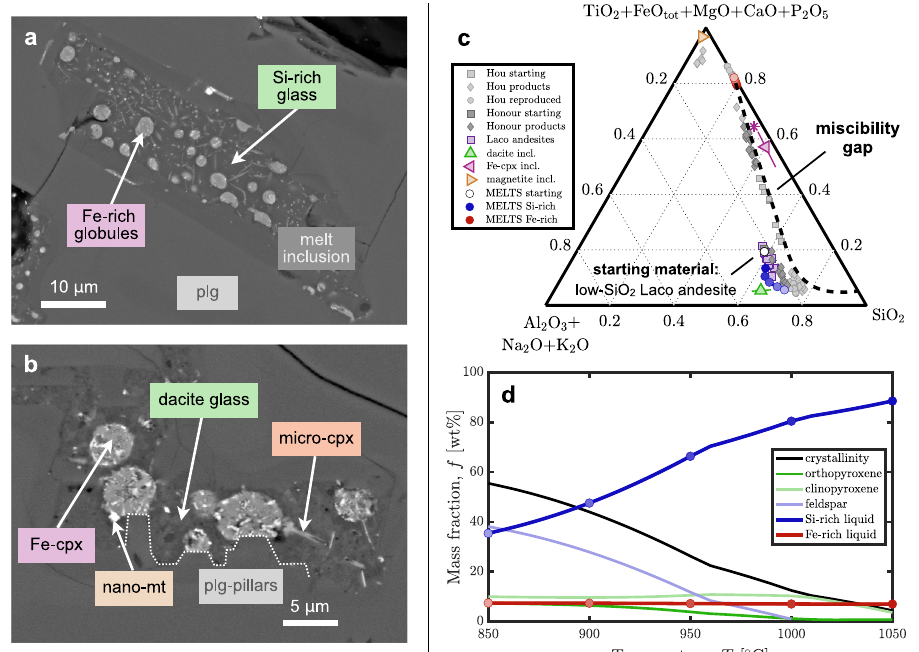
Fig.3|LiquidimmiscibilityinElLacoandesite. Back-scatteredelectronimagesof plagioclase-hosted (plg) melt inclusions from ore-hosting andesites; a Fe-rich glo- bules in Si-rich matrix; b higher magni fi cation image shows high-SiO 2 dacite glass matrix with some clinopyroxene micro-phenocrysts (micro-cpx), and Fe-rich glo- bulescomprisedofFe-clinopyroxene(Fe-cpx)withsomenanocrystallinemagnetite (nano-mt); plagioclase shows pillar structures indicative of melt unmixing during crystallisation 19 .Modellingofclosed-systemisobariccoolinginalphaMELTSshown at50°Cintervalsfrom1050°C(darker)to850°C(lighter)in( c )predictSi-richmelt